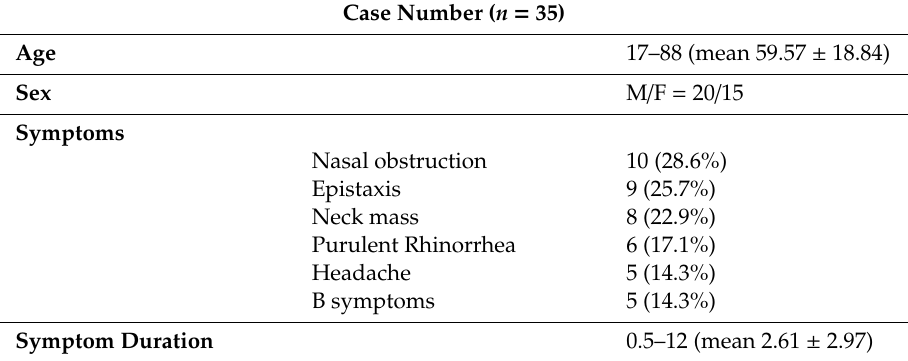
Table 1. Demographic, clinical, and histological information of patients with NP